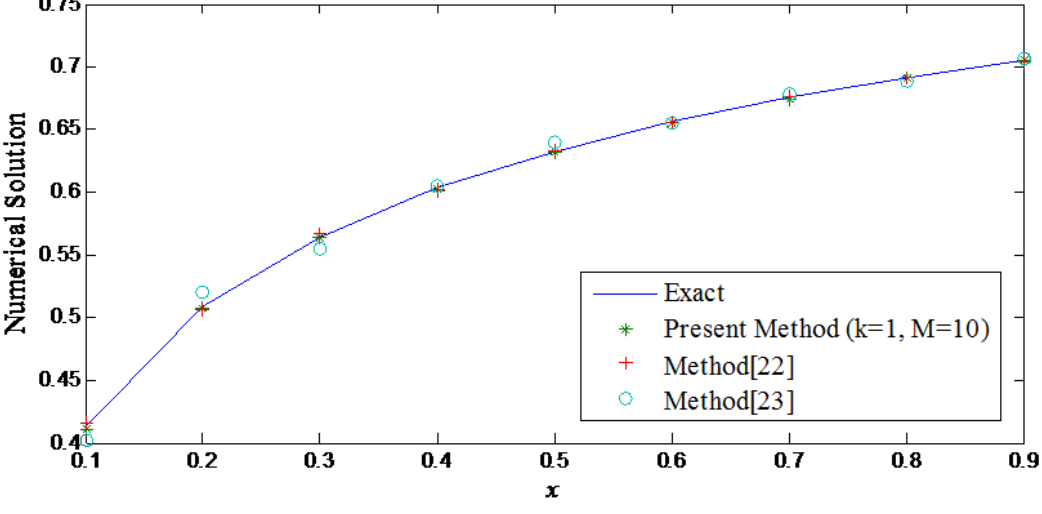
Fig. 5 Comparison of Numerical solutions of example 4.